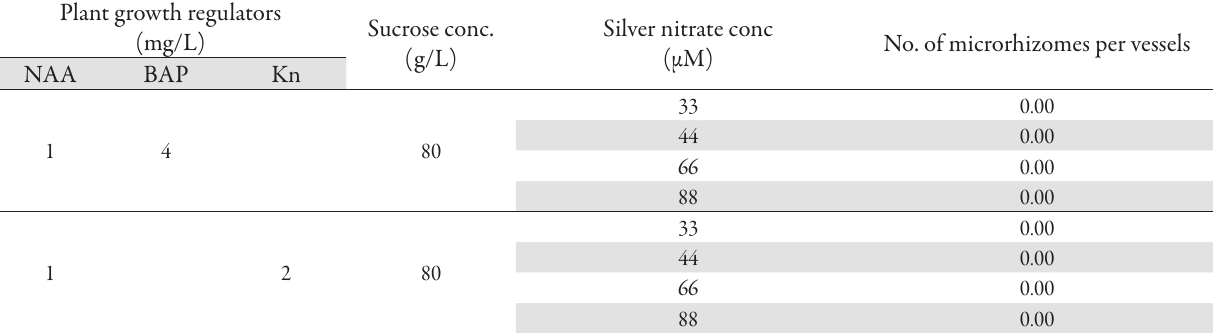
in in vitro microrhizome production (n = 20) 3